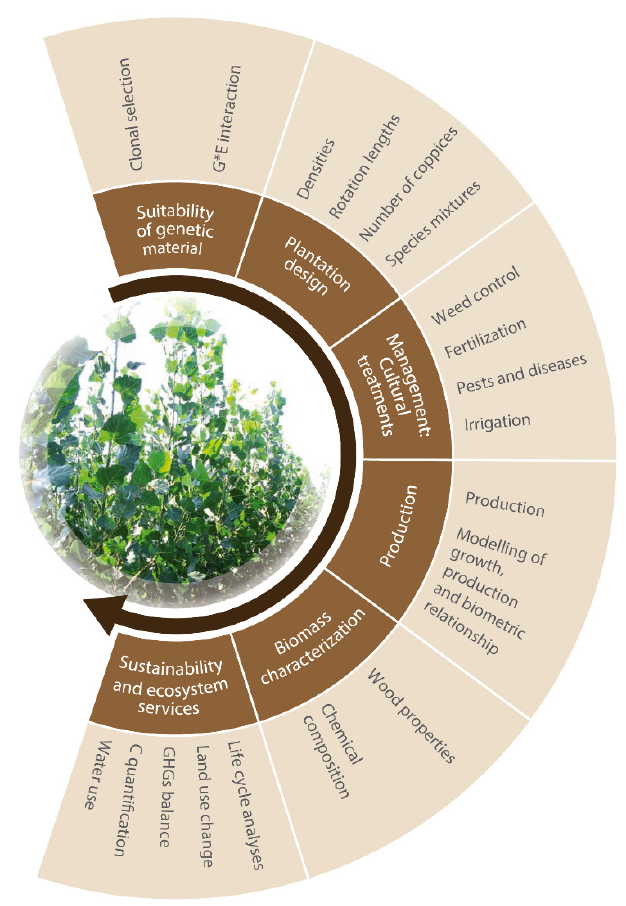
Figure 2. Lines of action for improving short rotation coppice-managed woody crops.